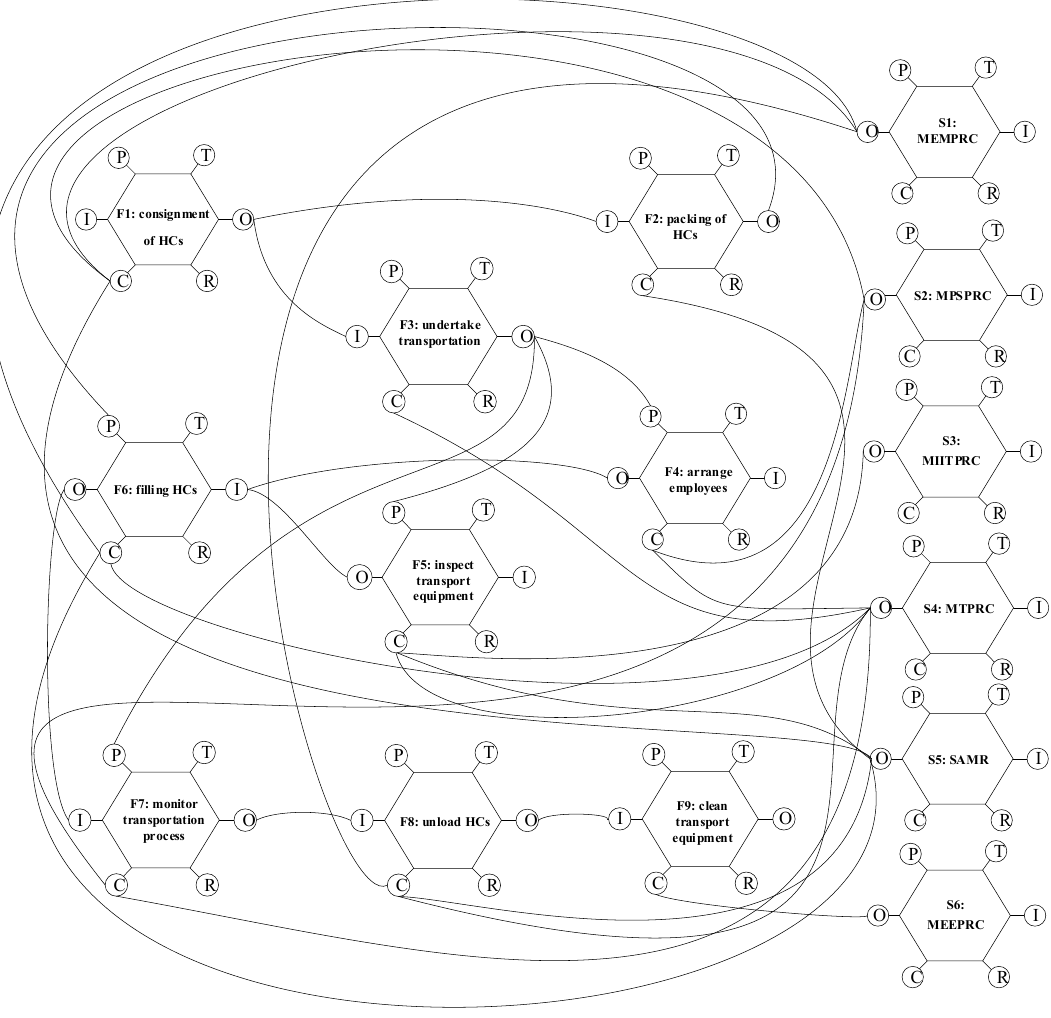
Figure 5. Function network of HCRTS by FRAM.